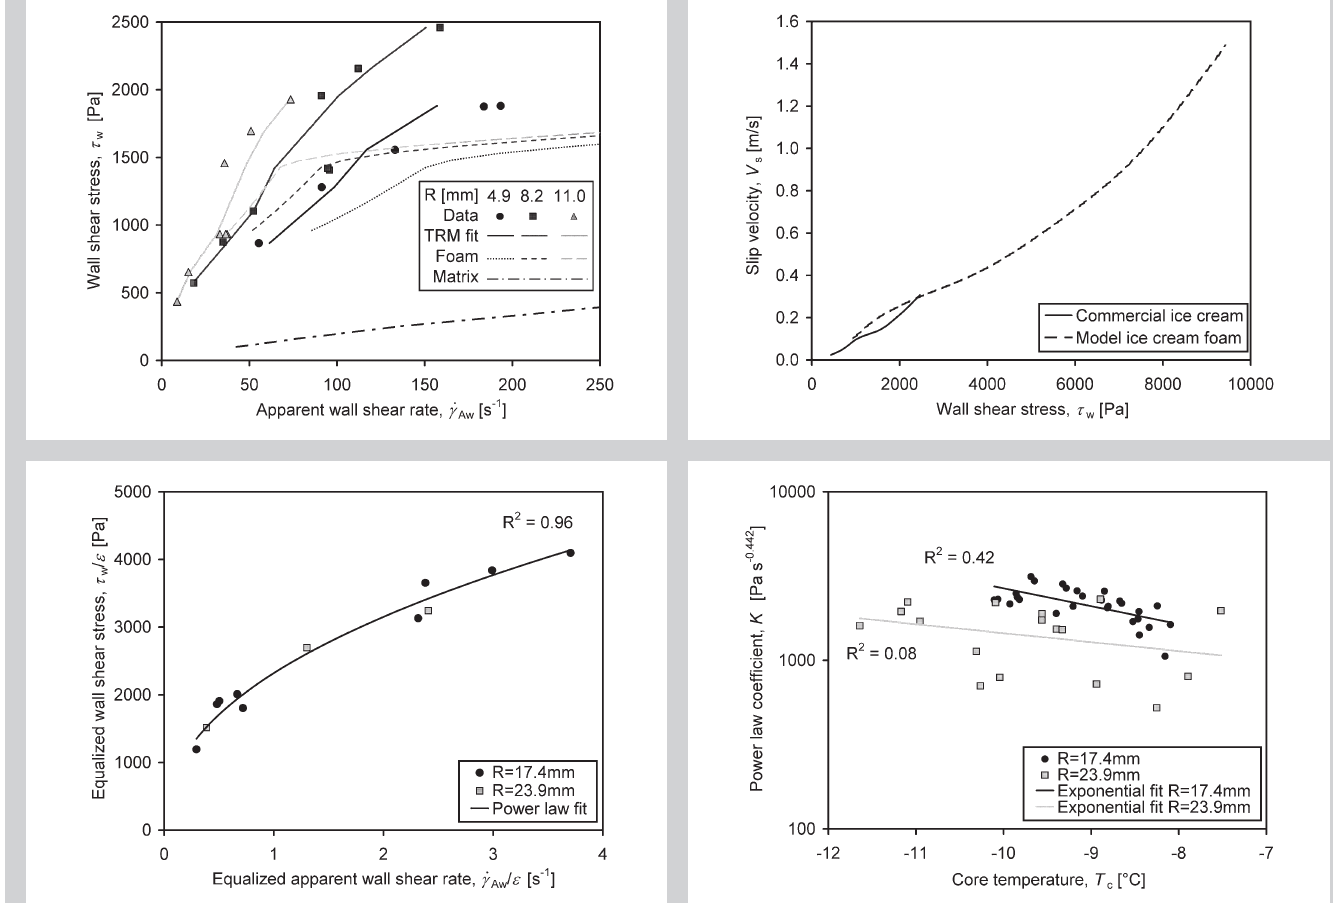
Figure 2 (left above): Ice cream flow data and fit- ted flow curves ( f = 0.11 ± 0.01, T = - 5.6 ± 0.3°C) c compared to fitted curves obtained for model foam and matrix ( f = 0.50 ± 0.15, = - 5.0 ± 0.1°C). T c Figure 3 (right above): Fitted ice cream wall slip ( f = 0.11 ± 0.01, T = - 5.6 ± c 0.3°C) compared to model foam wall slip ( f = 0.50 ± = - 5.0 ± 0.1°C). 0.15, T c Figure 4 (left below): Ice cream flow data and fitted flow curves at larger radii, where wall slip is negligible ( f = 0.24±0.05, T = -9.5±0.6°C). c Figure 5 (right below): Ice cream power law coeffi- cient K against temperature for n = 0.442 ( f = 0.24 ± = -9.5 ± 0.05, T c